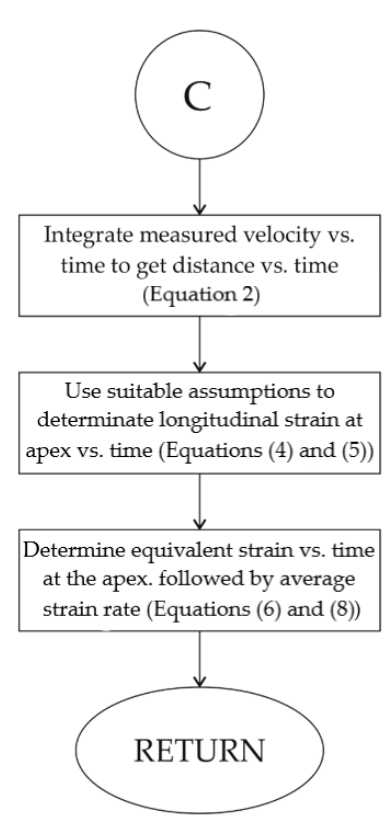
Figure A4. Continuation of the main routine.